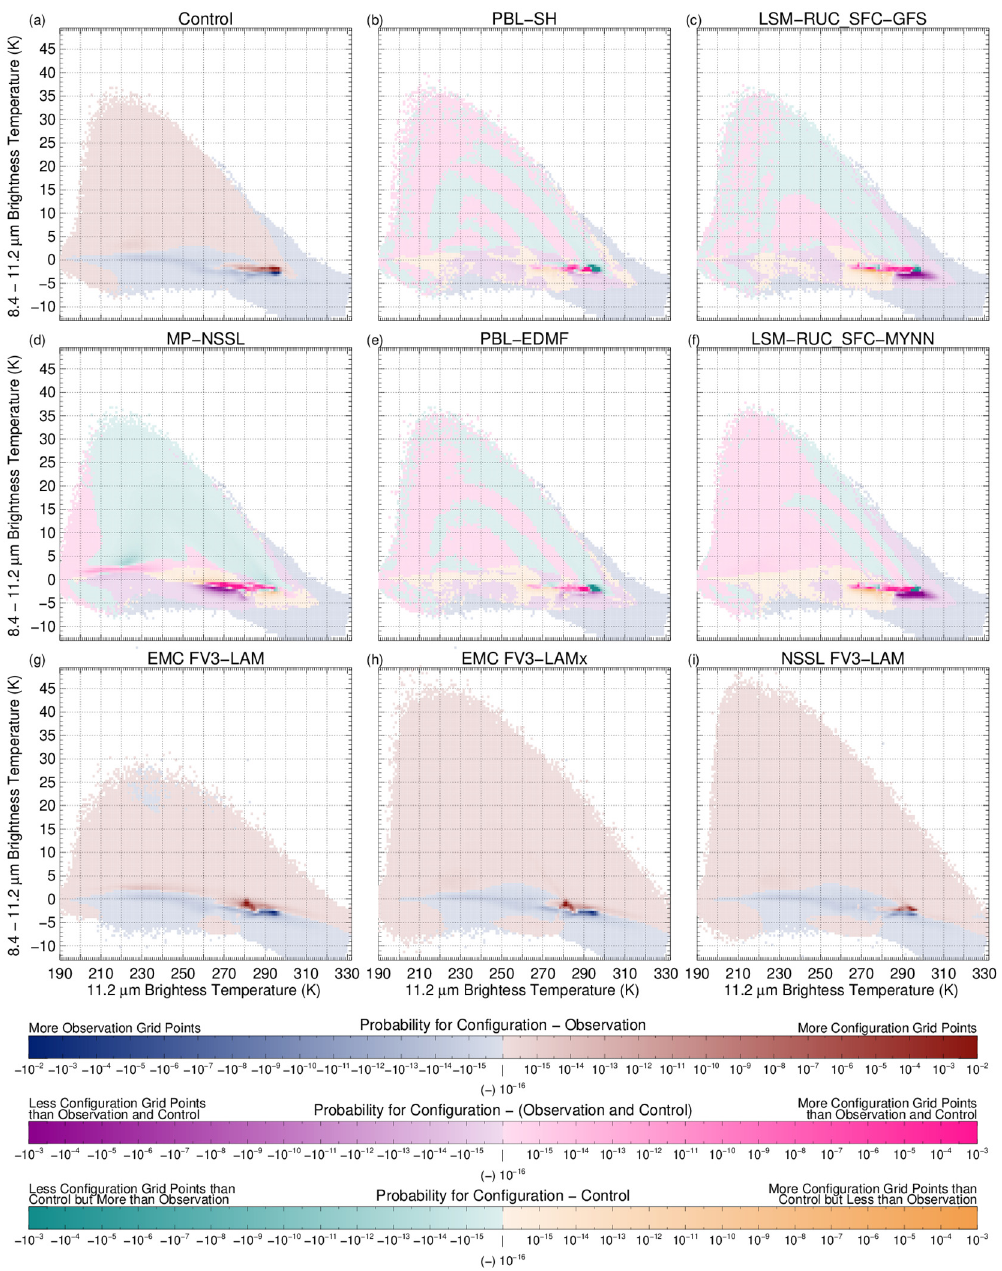
Figure 8. Histograms of GOES-16 ABI 8.4–11.2 µ m brightness temperature differences plotted as a function of the ABI 11.2 µ m brightness temperature ( a – i ). Red (blue) shading in the first color bar indicates a higher (lower) number of grid points with a given BTD and 11.2 µ m BT combination for the configuration compared to the observations. Purple (pink) shading in the second color bar indicates a given configuration has fewer (more) grid points at the given BTD and 11.2 µ m BT combination than both the observations and Control. In the third color bar, green indicates the configuration also has more grid points than the observations for a given combination but fewer than Control, while orange indicates that the configuration has more grid points than Control but fewer than the